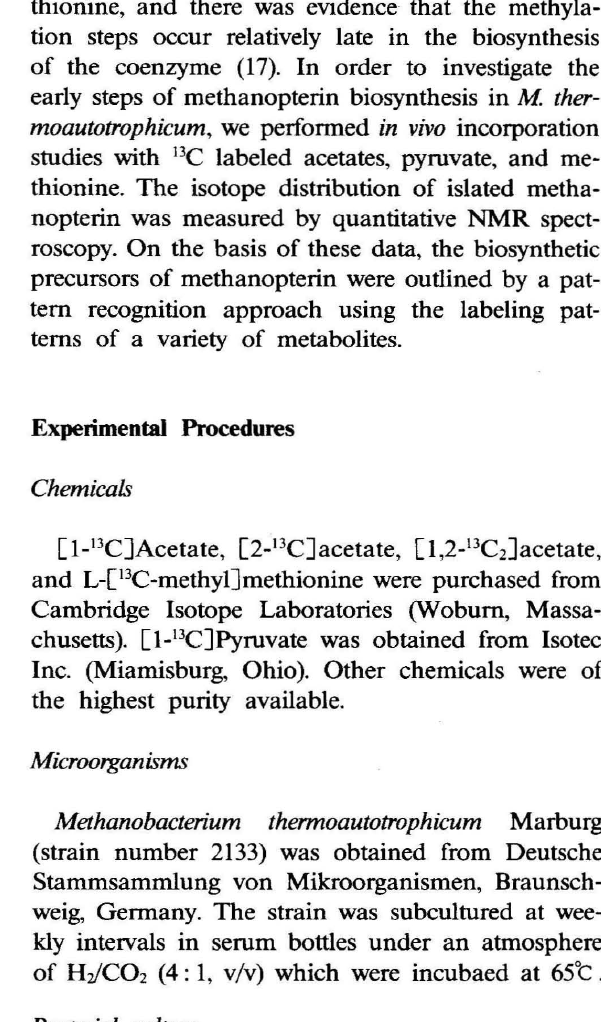
Figure 1. Structures of methanopterin (1), sarcinapterin (2), tatiopterin (3), and the "hydrolytic fragment" of methanopterin (4).